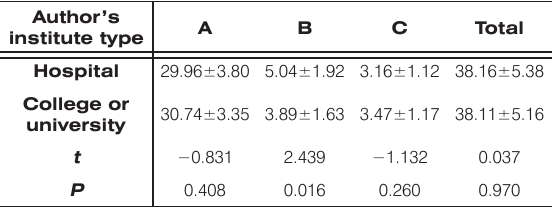
Table 5. Comparison of the evaluation scores of clinical nursing studies by authors from different types of institutes Note: A: Level of the study; B: Value of the result; C: Effectiveness of the result.